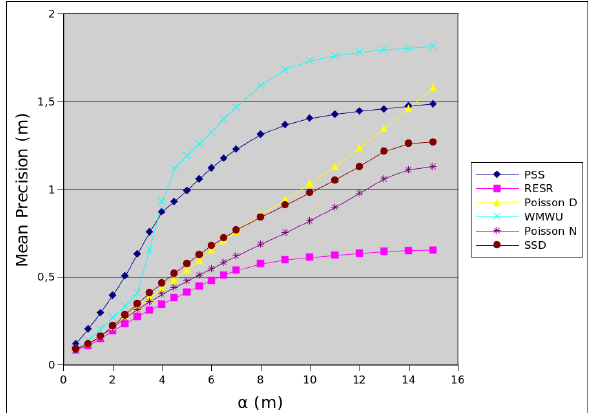
Figure 4. Mean Precision